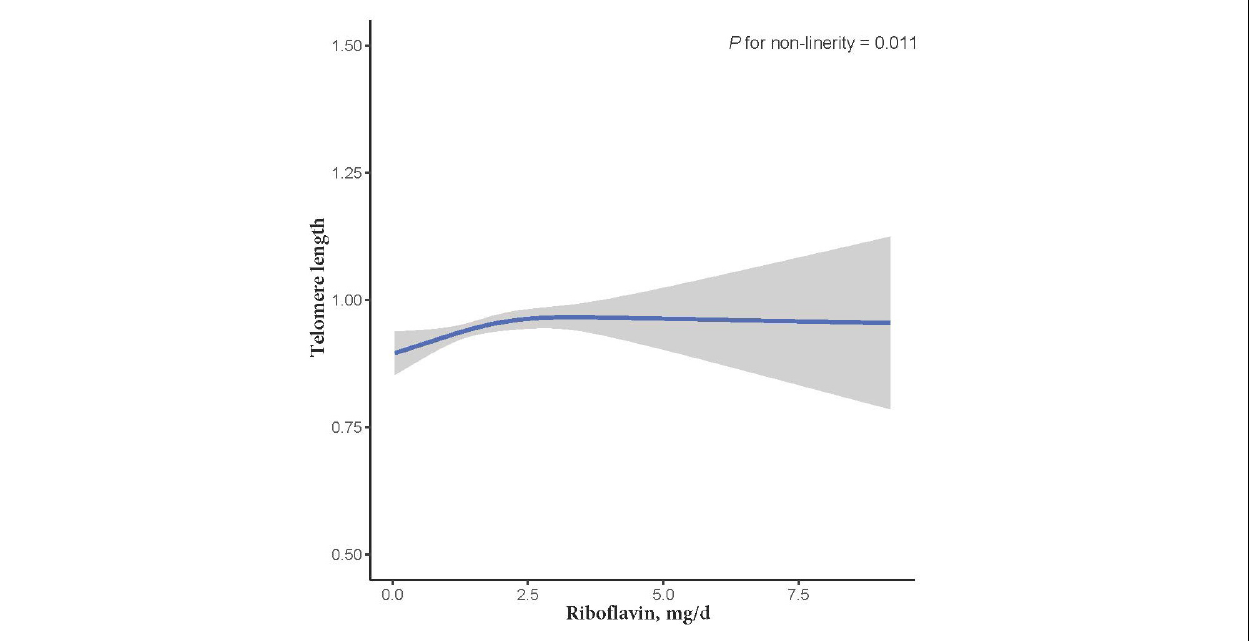
Frontiers in Nutrition |